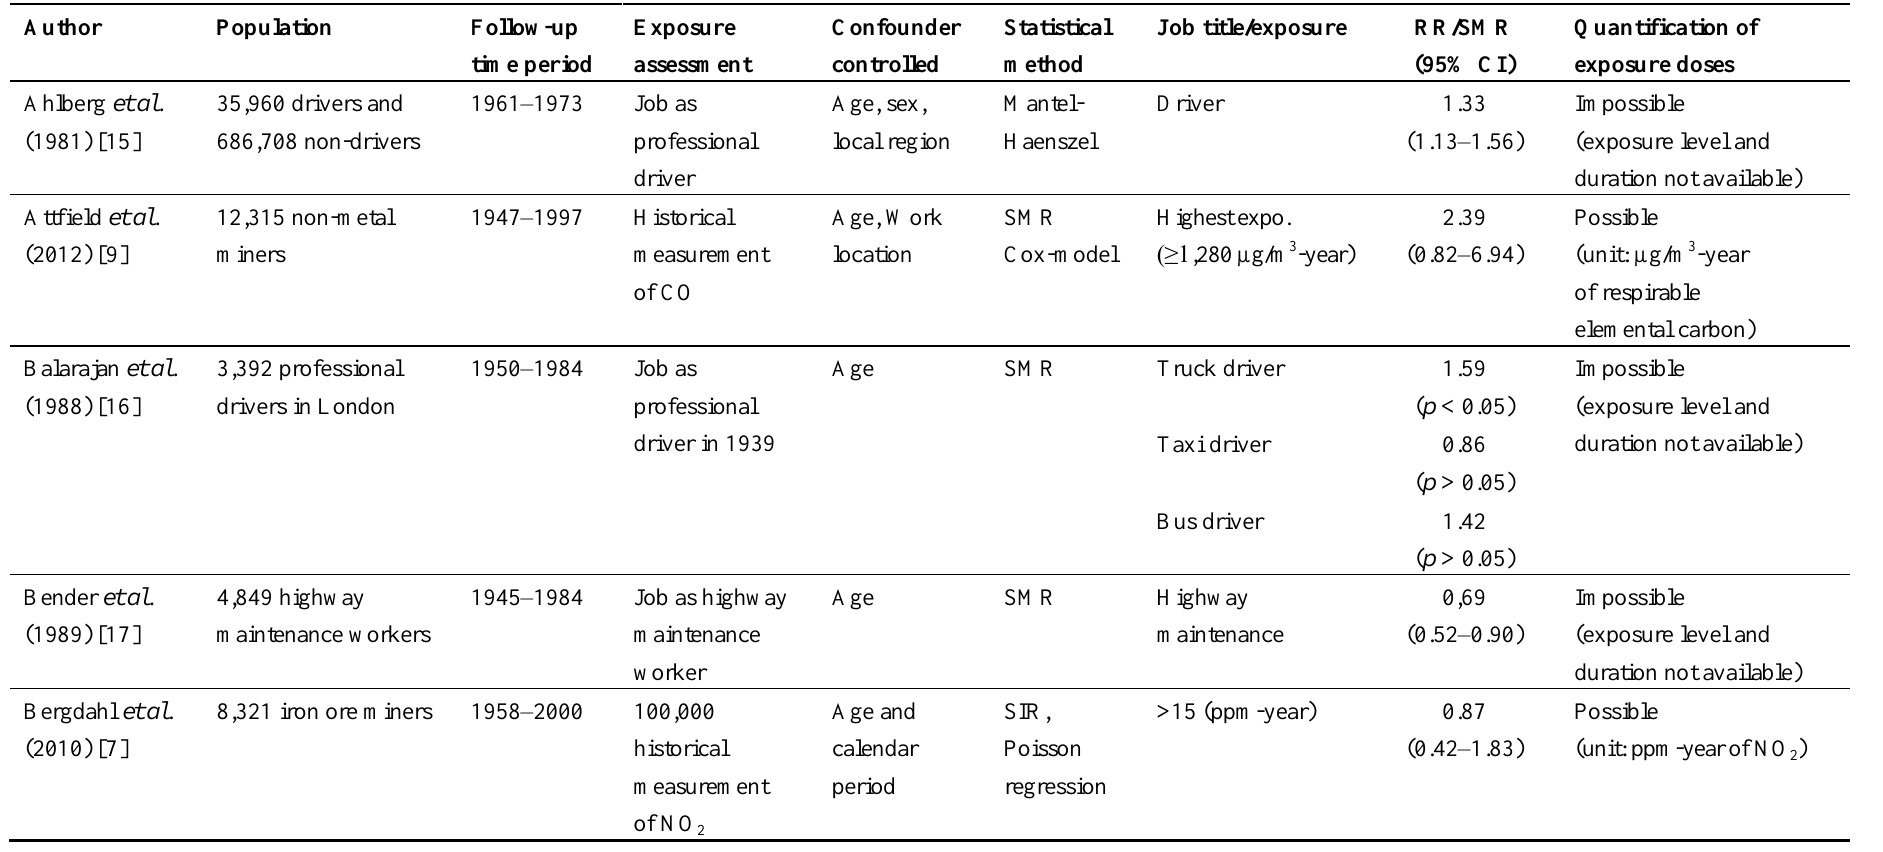
Table 2. Cohort studies on diesel exhaust exposure and lung